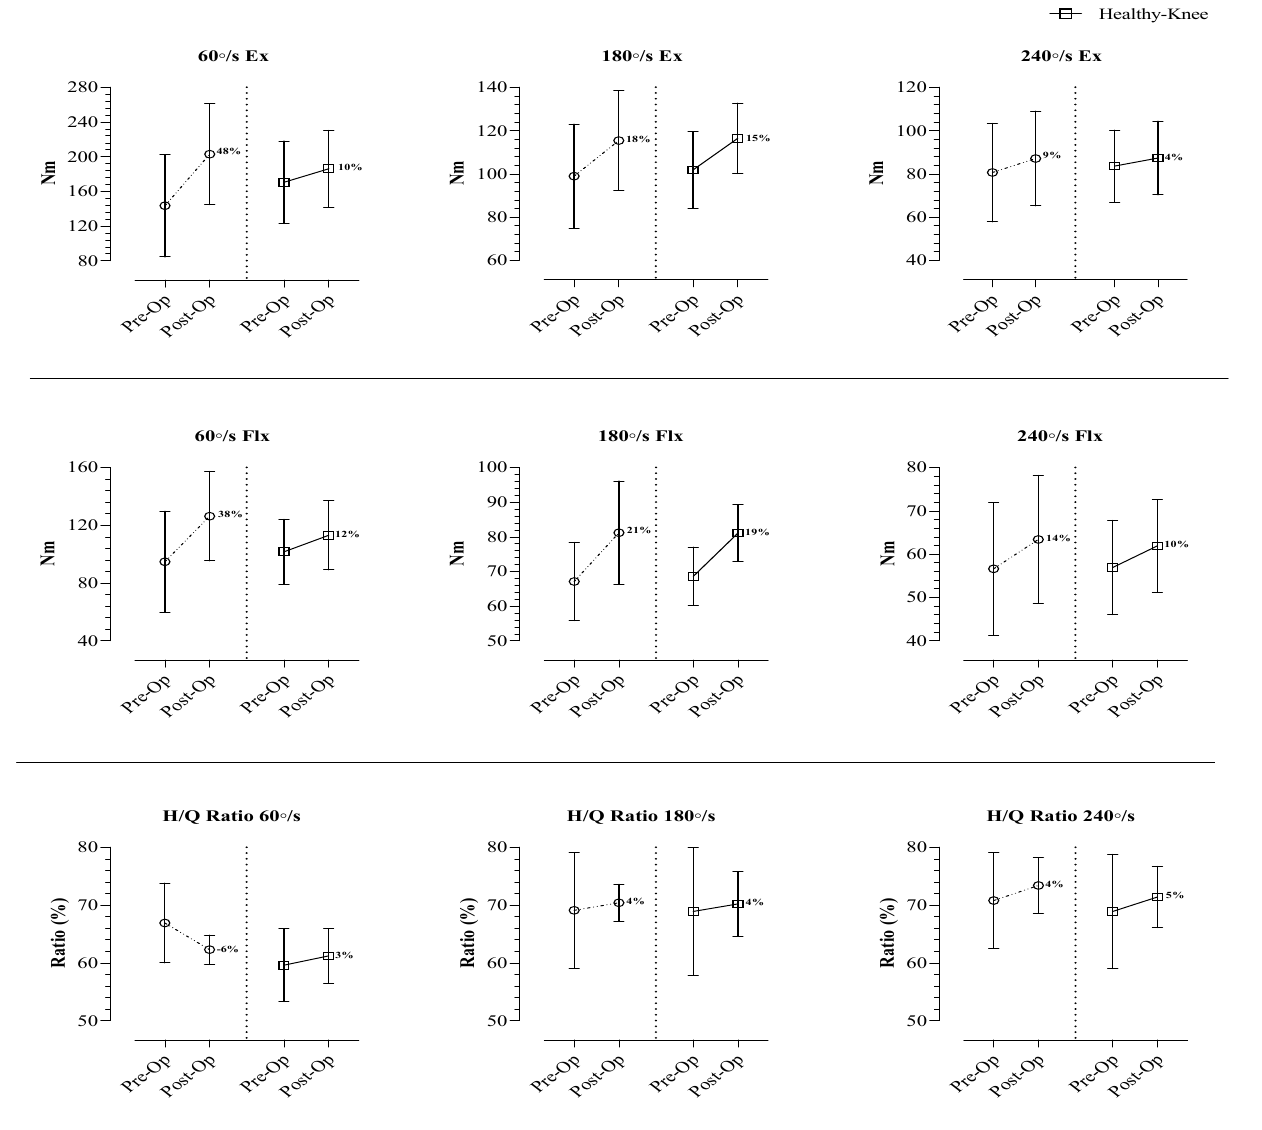
Figure 3. Percentage changes of difference between pre- and post-ACL-Knee (left side of graph) and Healthy-Knee groups (right side of graph).